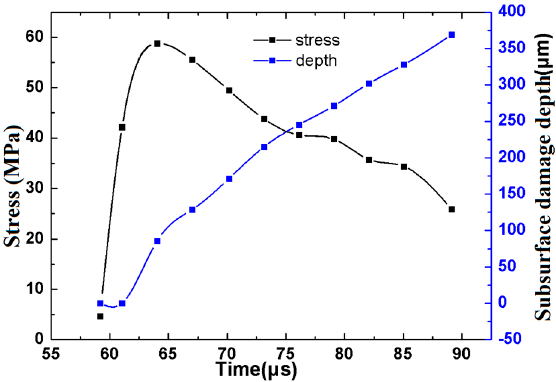
Figure 7. Relationship between stress, subsurface damage depth, and step time of path 5.